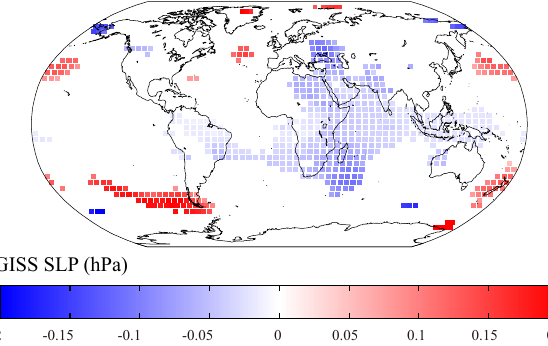
Fig. 9. Composite SLP differences in the GISS simulation (using the same data as in Fig. 8 except for the SLP). Grid data with 90% confidence levels, calculated by re-sampling (two-sided test), are shown in